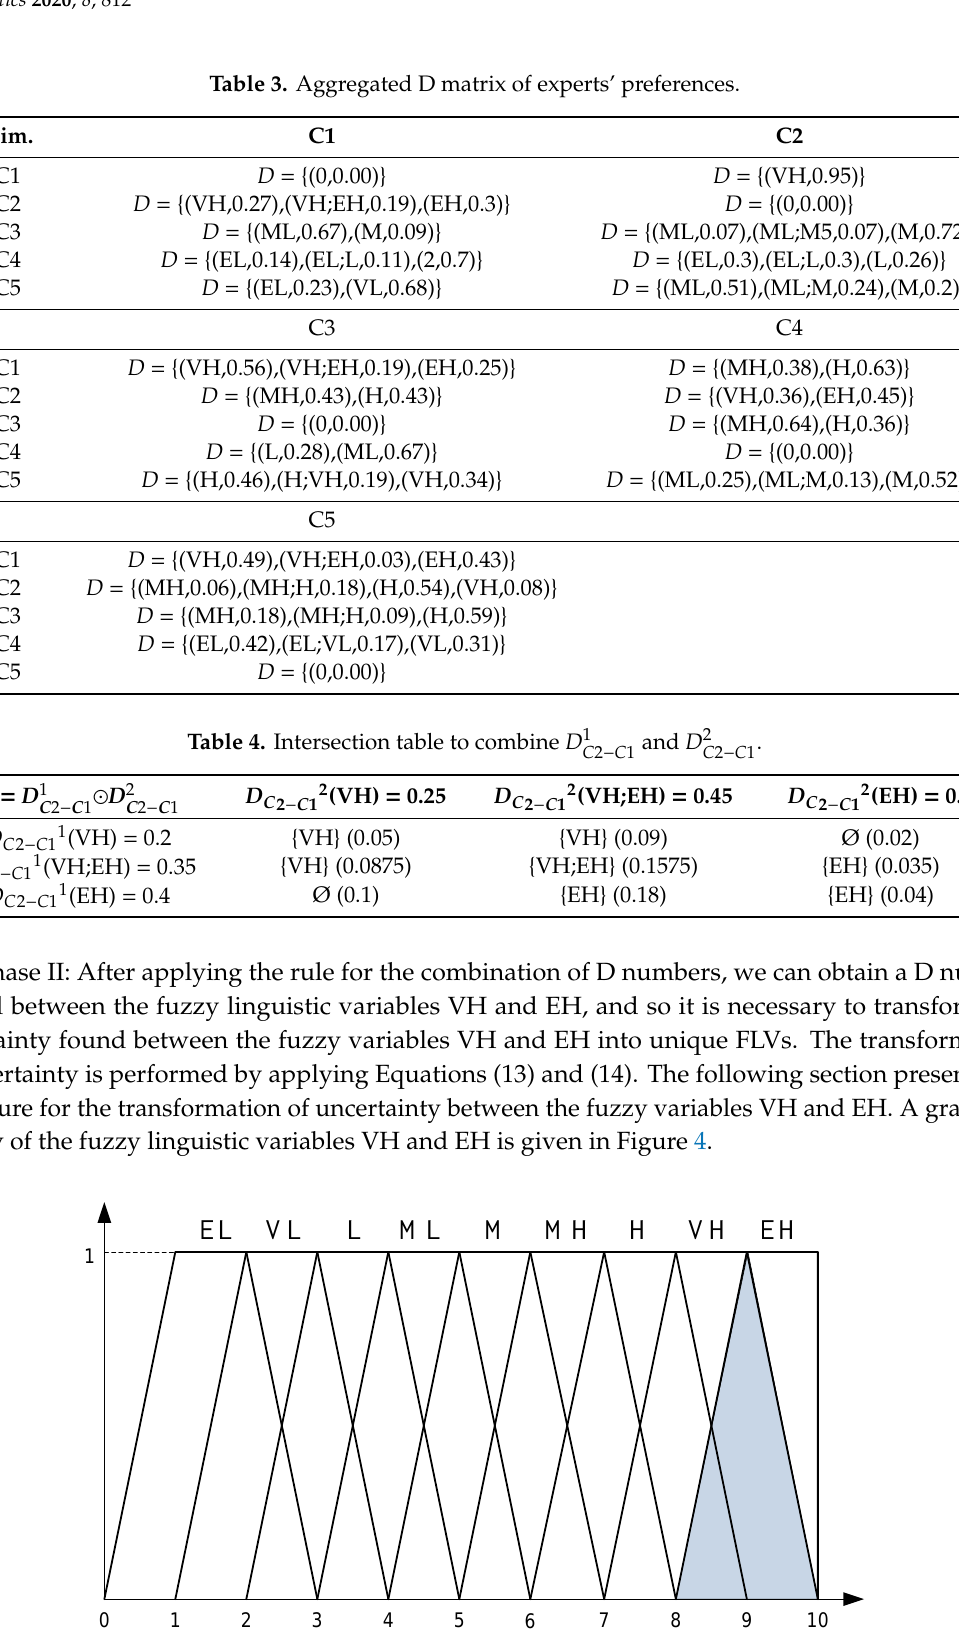
Table 3. Aggregated D matrix of experts’ preferences.